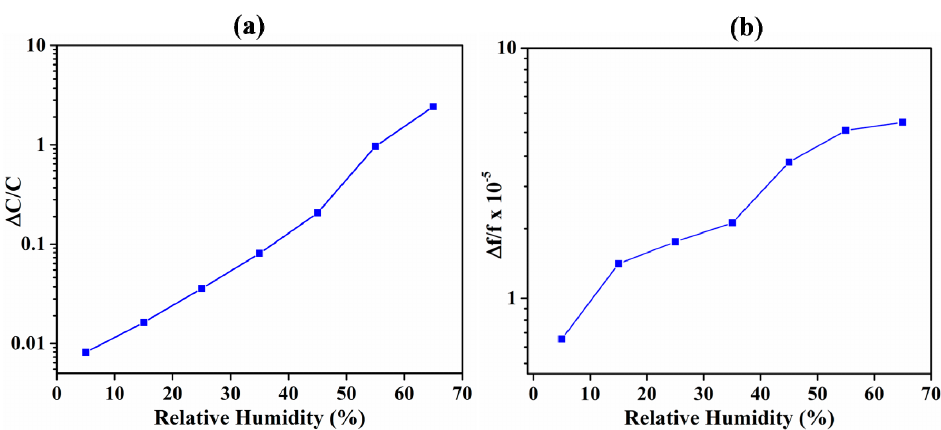
Figure 8. Sensitivity of the ZIF-8-coated sensors to humidity. ( a ) Sensitivity response of the capacitive sensor. ( b ) Sensitivity response of the QCM-based sensor.